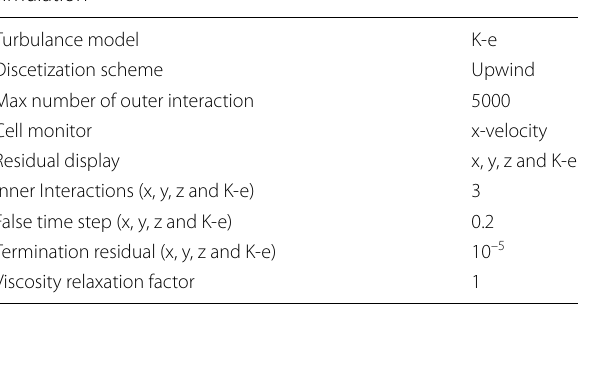
Table 1 CFD control setting panel: values adopted for